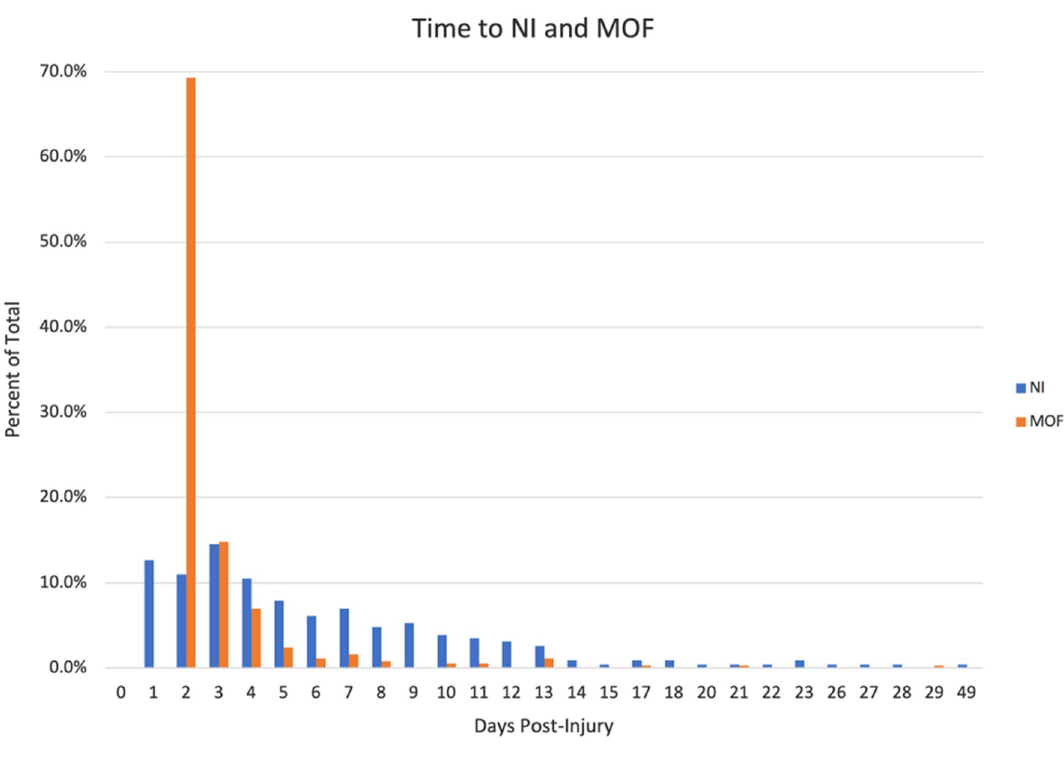
Figure 2. Time to NI and